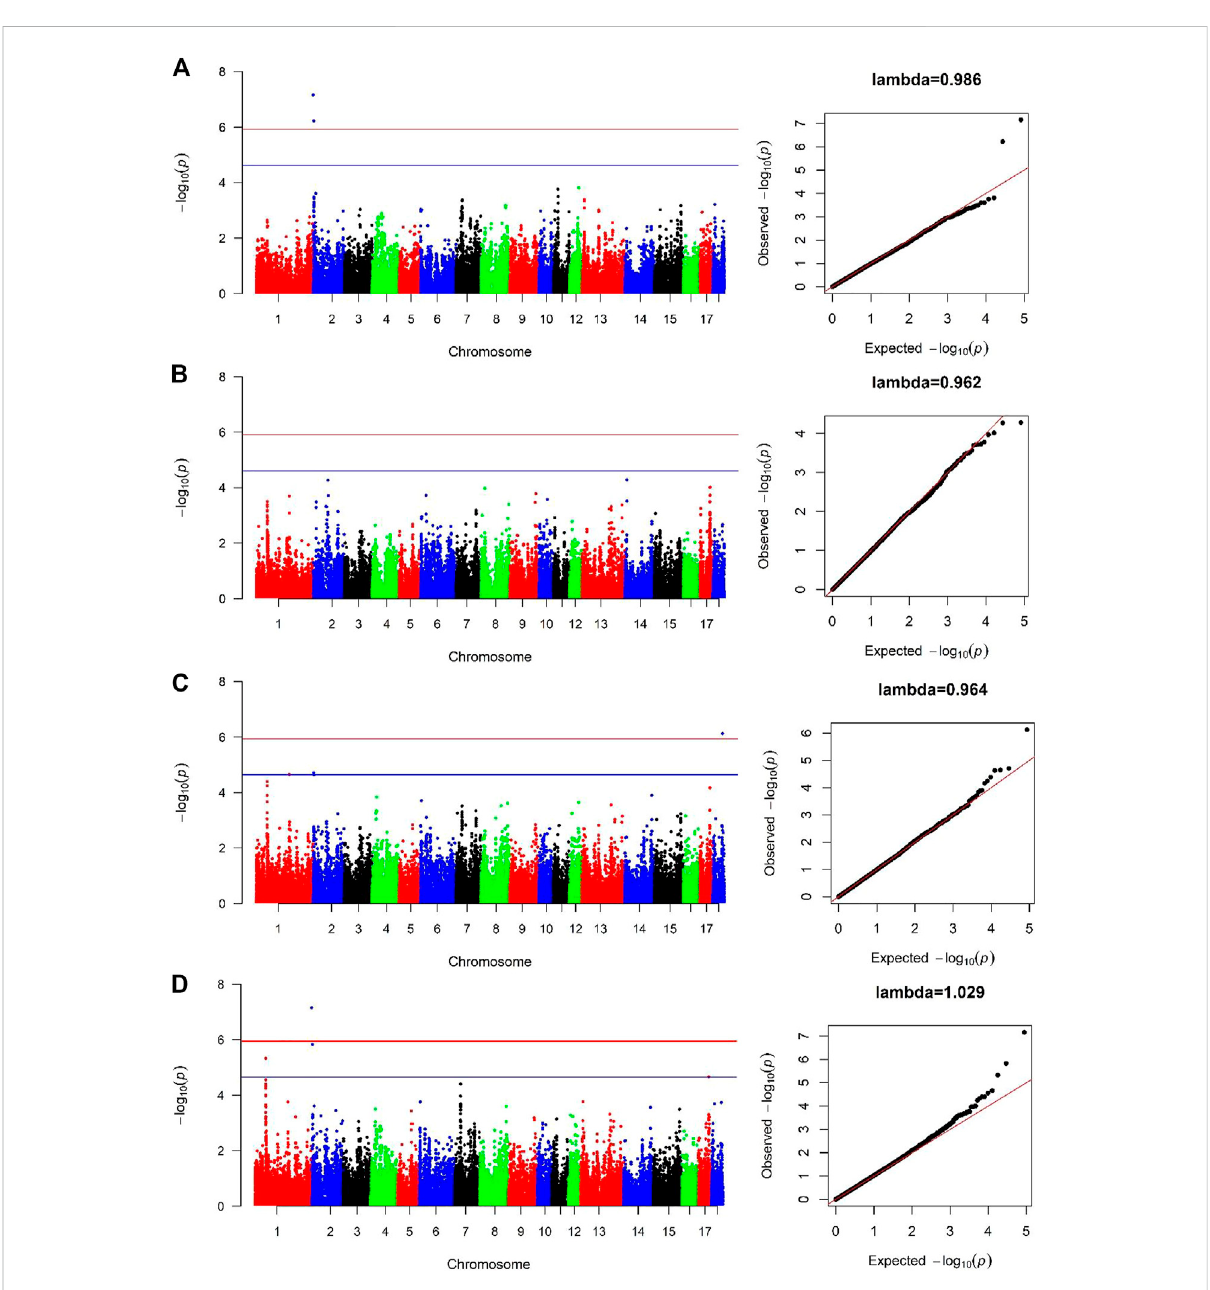
FIGURE 3 Manhattan and Quantile-Quantile (QQ) plots of genome-wide association analysis for BF100 trait. (A) is Canadian line. (B) is French line. (C) is combined-population. (D) is cross-population GWAS. The x-axis denotes autosomes. The y-axis indicates -log 10 ( p -values).